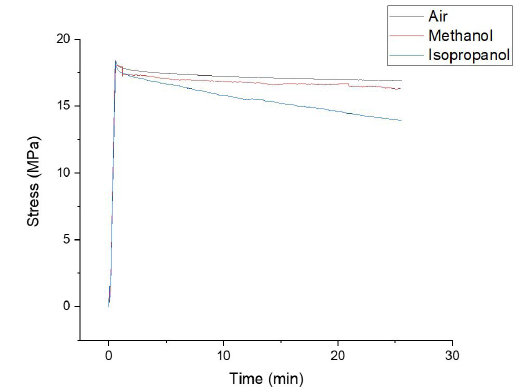
Figure 5. Simple relaxation test curves of 200 kGy PC in three different environments.